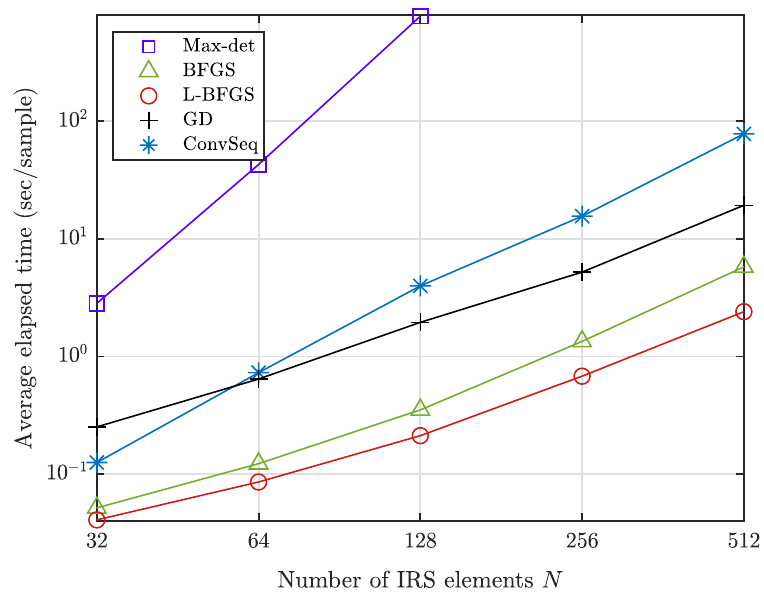
Figure 4. Computational time of unit modulus reflection as the number N of IRS elements increases when M = 2 and K =